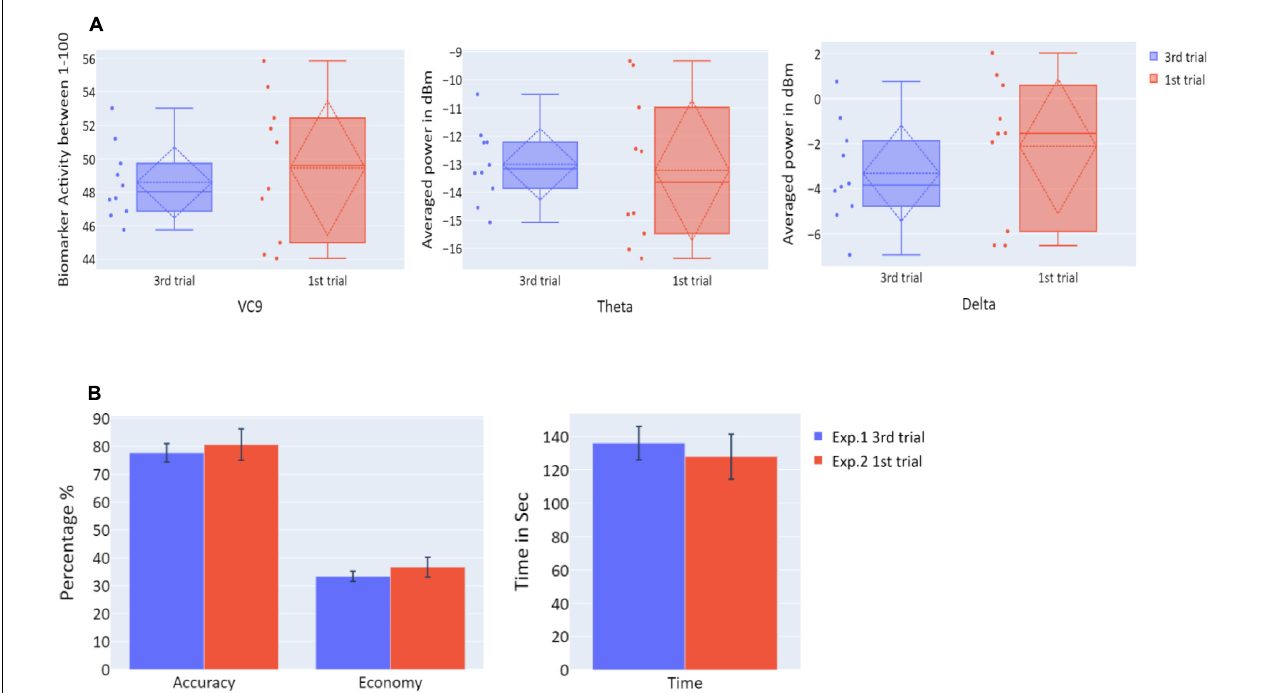
FIGURE 8 | (A) The distribution of VC9 (normalized between 1 and 100), theta (averaged power of 4–7 Hz in dBm), and delta (averaged power of 0.5–4 Hz in dBm), obtained in the last trial repetition of Experiment 1 (blue), and the first task repetition of Experiment 2 (red), for participants who participated in both Experiment 1 and Experiment 2 ( n = 10). Dashed lines represent means and SDs. (B) The means of accuracy (in percentage), economy of movement (in percentage), and time to exceed the task (in seconds), obtained in the last trial repetition of Experiment 1 (blue), and the first task repetition of Experiment 2 (red), for participants who participated in both Experiment 1 and Experiment 2 ( n = 10). Error bars represent standard errors.